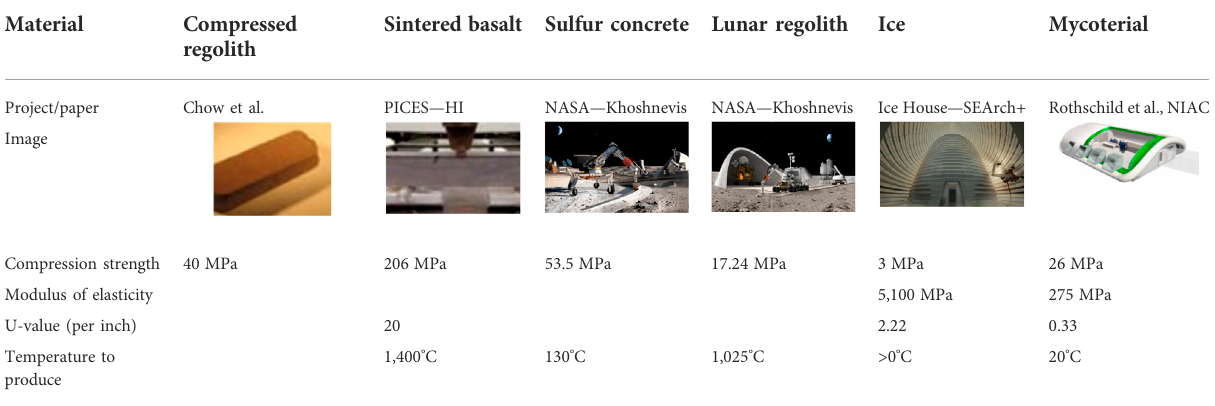
TABLE 2 Material comparison with materials under consideration for ISRU construction (Khoshnevis et al., 2012; Rothschild et al., 2018; Chow et al., 2017; Taylor and Meek, 2005; Romo et al., 2017). Material